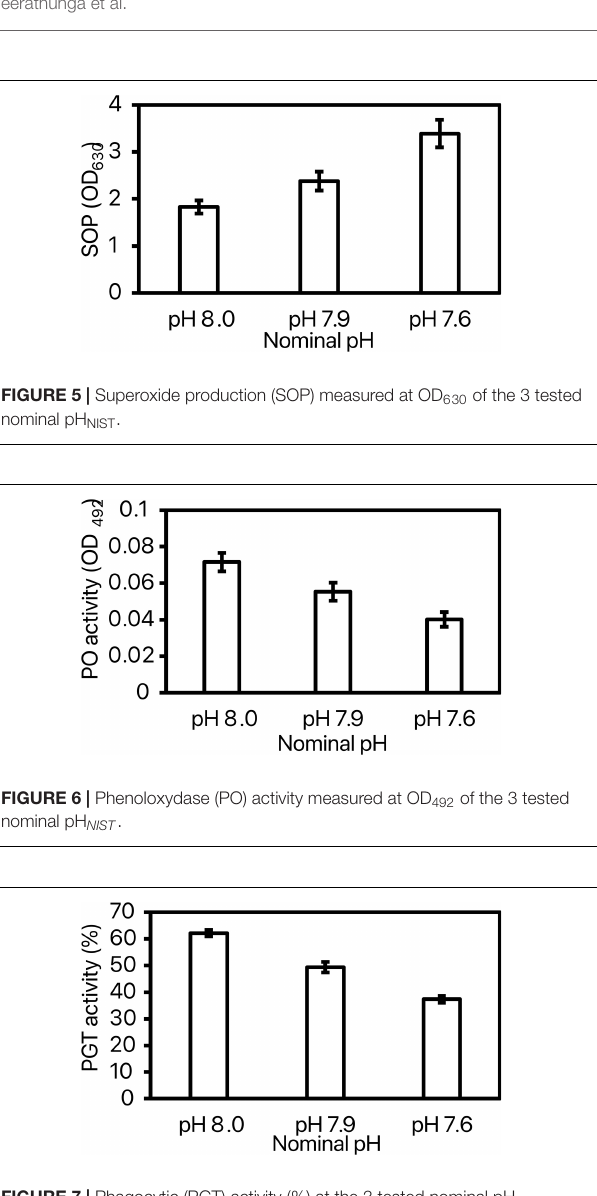
FIGURE 7 | Phagocytic (PGT) activity (%) at the 3 tested nominal pH NIST